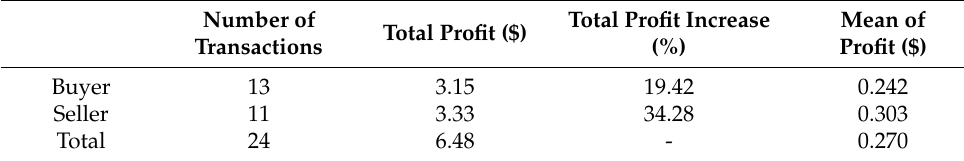
Table 3. Result of the double auction mechanism with original bidding